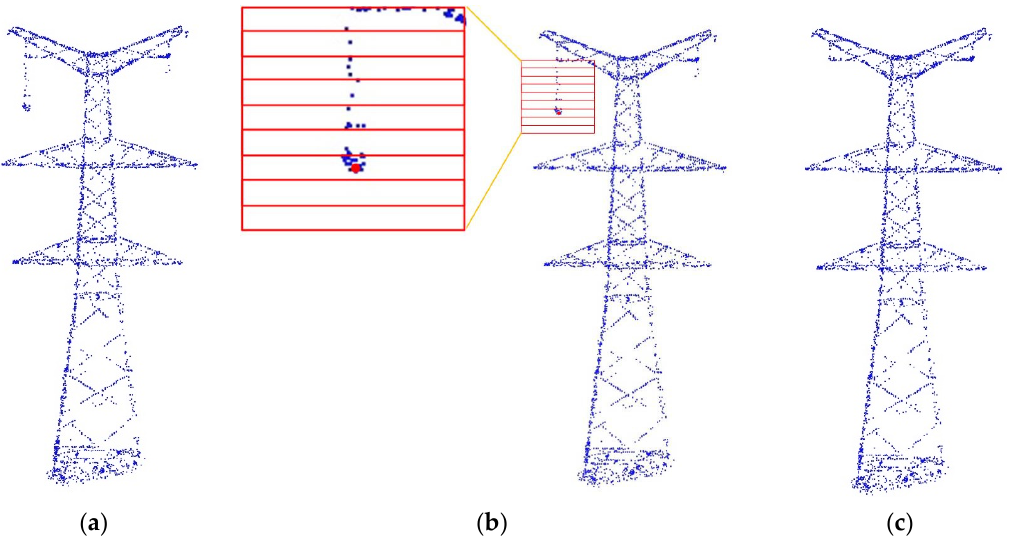
Figure 5. Error elimination: ( a ) the pylon extraction result using graph cut; ( b ) the vertical bins; and ( c ) the power-line based error elimination.